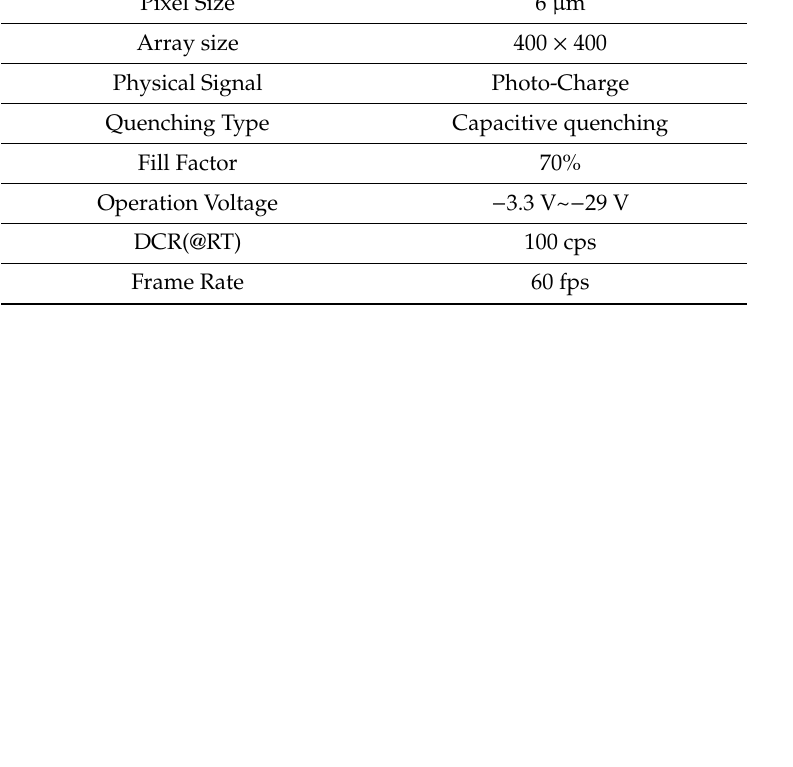
Table 2. Specifications of the fabricated SPAD-based CMOS image sensor (CIS).